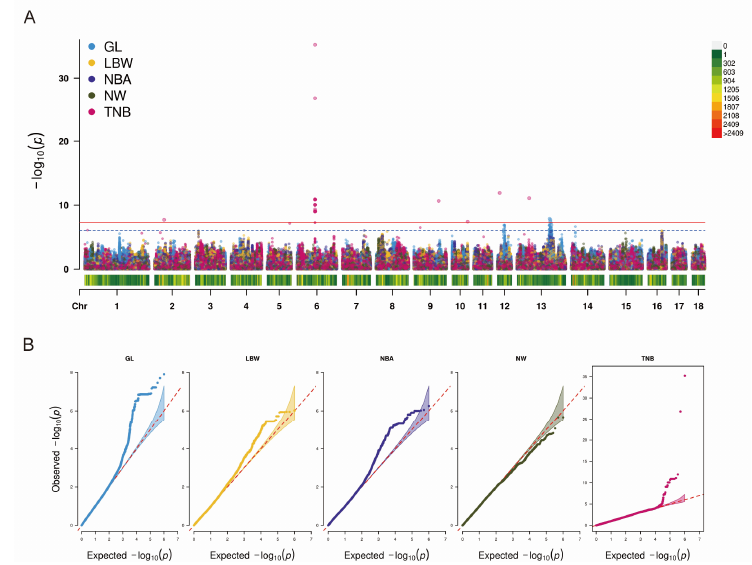
Figure 2. Manhattan and Q-Q plots of GWAS based on data imputation using PHARP for five reproductive traits. ( A ) The red line represents the genome-wide significance level (4.91 × 10 − 8 ). The blue line represents the suggestive significance (9.83 × 10 − 7 ). ( B ) Q-Q plots of five reproductive traits. Abbreviations: GL = gestation length, LBW = litter birth weight, NBA = number born alive, NW = number of weaned, TNB = total number born. Table 5. The significant SNPs in the genome with the total number born (TNB) and gestation length (GL) traits using data imputed with PHARP.